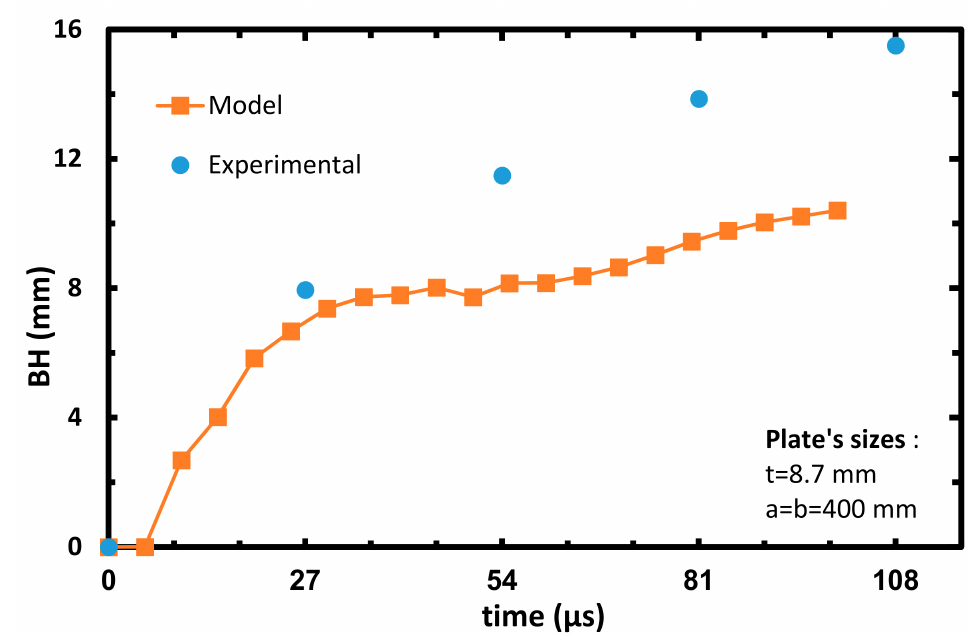
Figure 16. Plate’s bulge height vs. time of the calibrated model, Vinitial = 606 m/s.